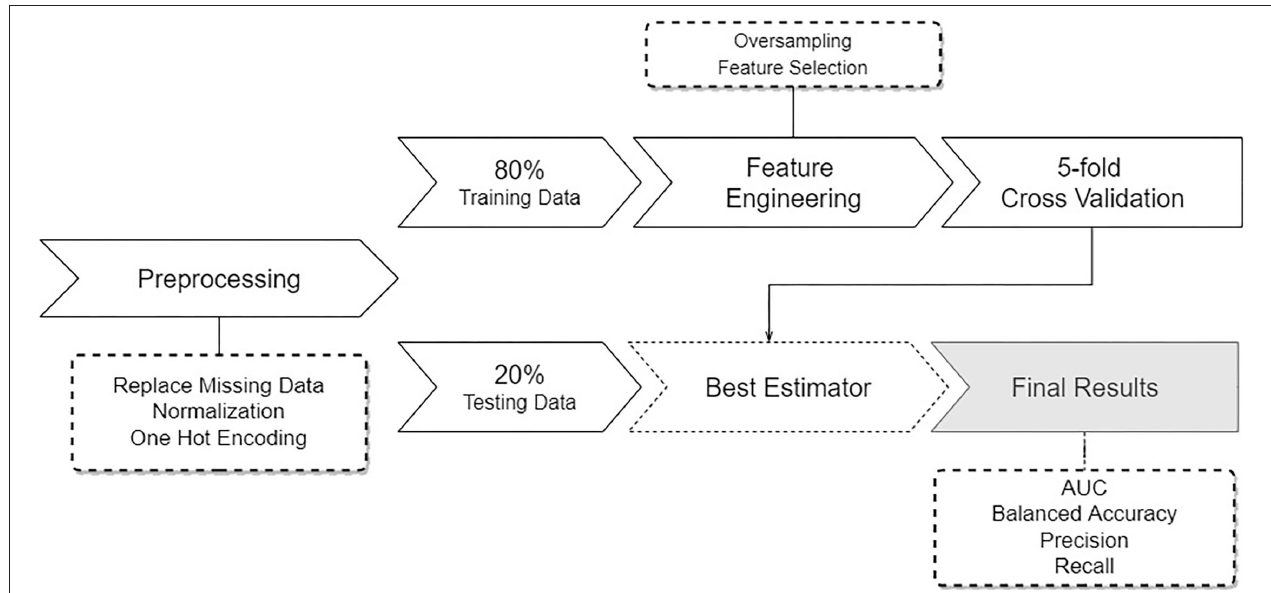
FIGURE 1 | Overview of the pipeline describing the developed approach. Starting with pre-processing of the data, followed by a data split, feature engineering and sampling, and subsequent training and testing several learning models.